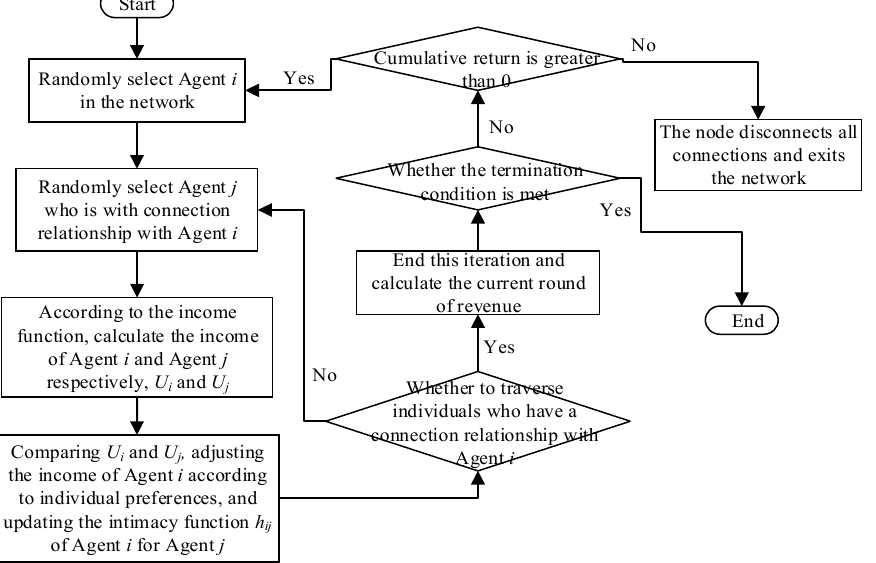
Figure 8. Simulation process of opinion evolution.